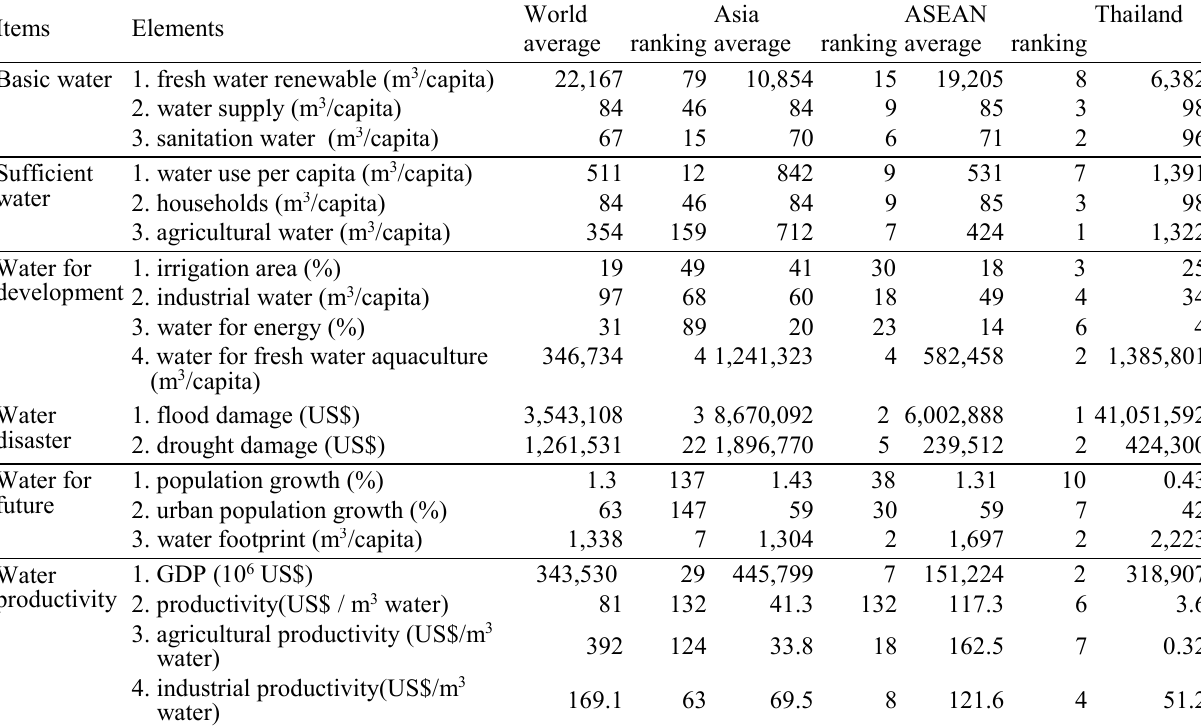
Table 1 The average world, Asia and ASEAN water use status and the ranking of Thailand.